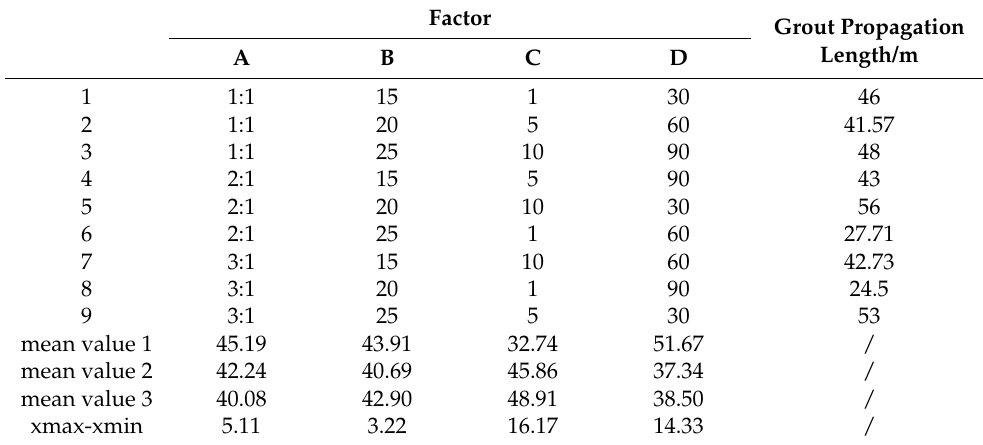
Table 10. Range analysis of numerical simulation